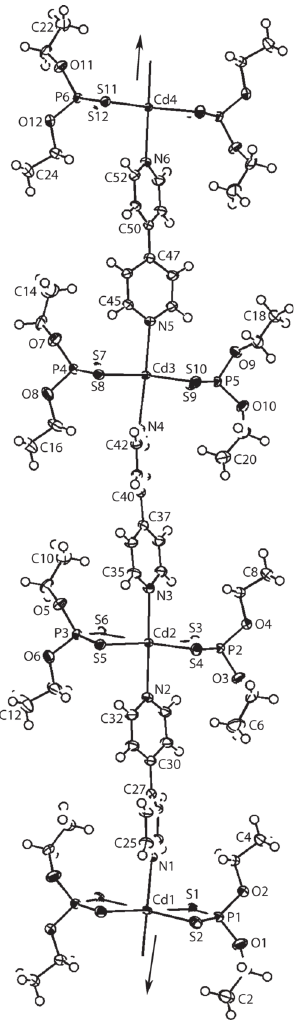
Table 1 contains crystallographic data and Table 2 contains the list of the atoms including atomic coordinates and dis- placement parameters.